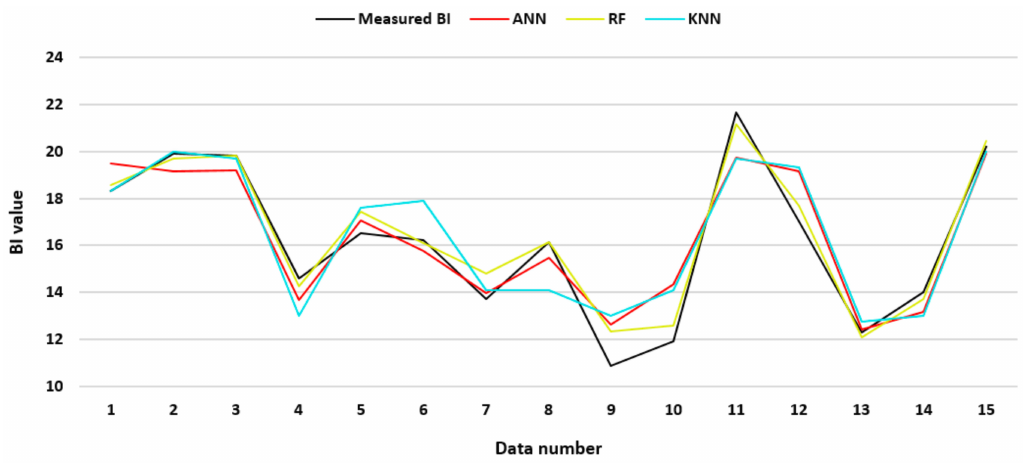
Figure 15. Predicted BI values by RF, ANN and KNN together with their measured BI for all 15 data